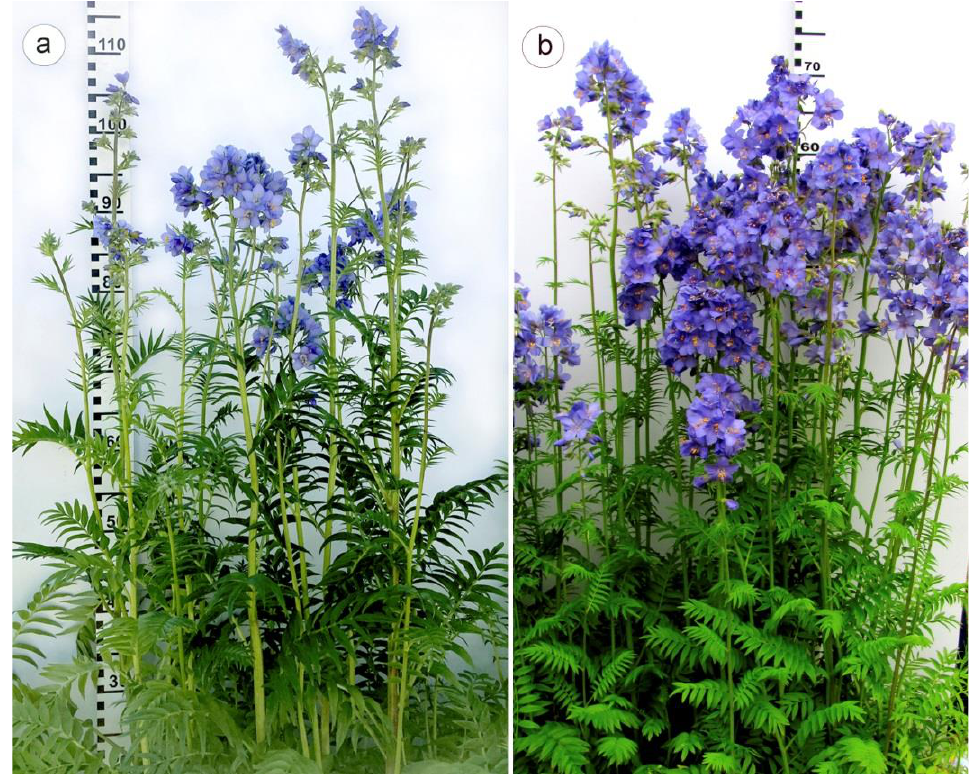
Figure 2. Flowering control diploid ( a ) and colchicine-induced tetraploid ( b ) plants of Polemonium caeruleum